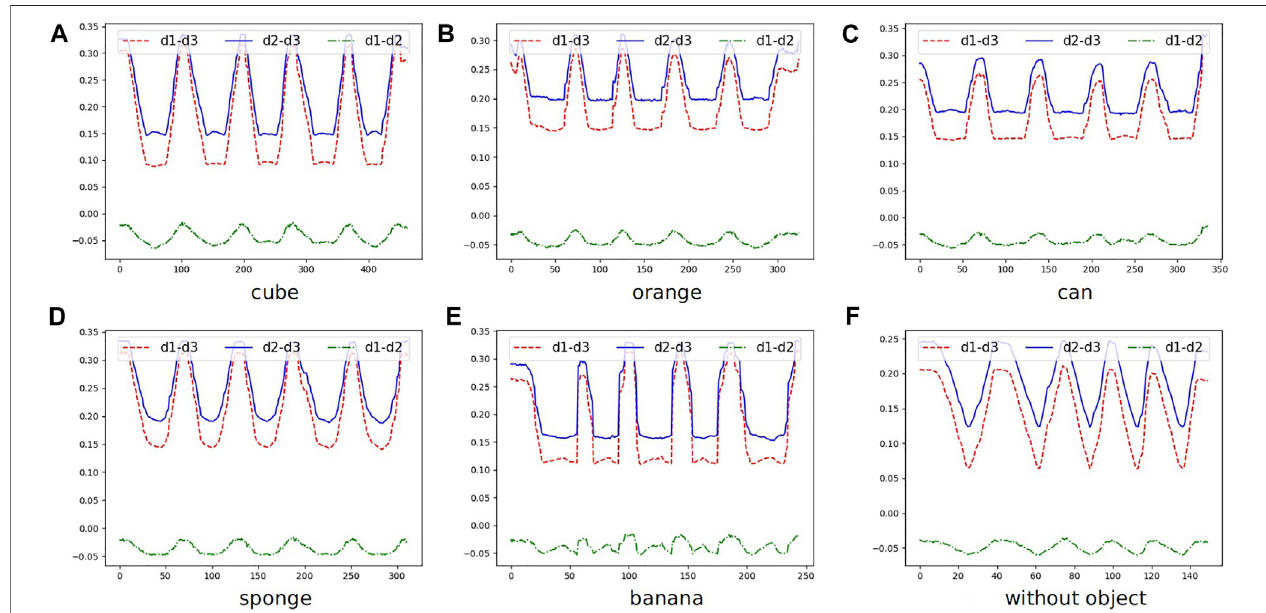
FIGURE 7 | The contact information of grasping fi ve objects( (A) : cube, (B) : orange, (C) : can, (D) : sponge, and (E) : banana) and no object (F) ) fi ve times. To emphasis the differences in interaction, we record subtraction of every two values of distance. d1 and d2 reveal the deformation of soft fi nger networks. d3 is linear and proportional to the closing distance of tongs. Therefore, the subtraction of d1 and d3, or d2 and d3, may provide information of geometry (lower value when grasped means smaller size of the object) and material (curve or straight line at valley reveals soft or solid material). The precise prediction will be exploited in the